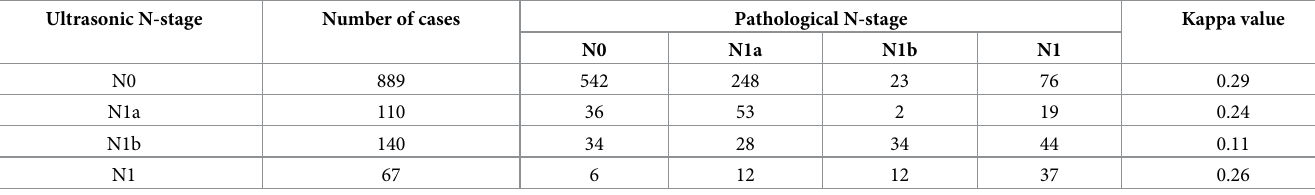
Table 6. The consistency between ultrasonic N-stages and pathological N-stages of DTC. Ultrasonic